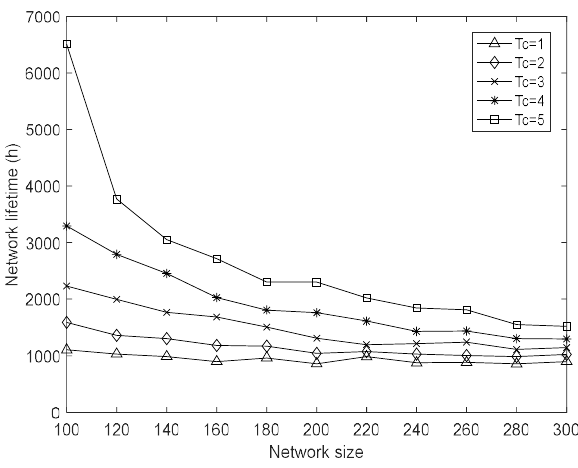
Figure 11. Network lifetime with varying network size.